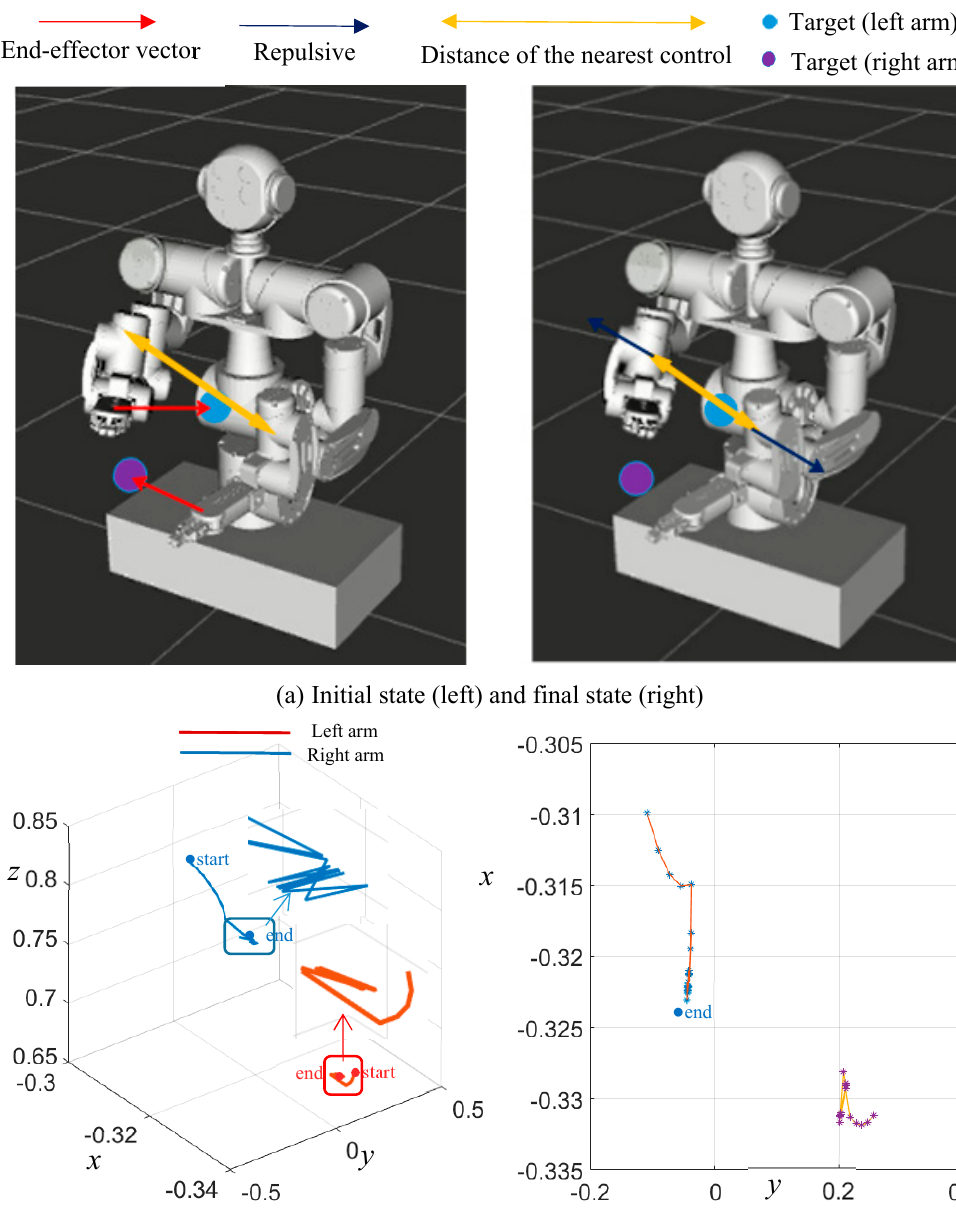
Figure 10. Process of avoiding self-collision in the dual-arm system using the traditional artificial potential field method. Two arms of the dual-arm had different targets. ( a ) The initial state and final state of the robot; ( b ) Trajectory of the end-effector of each arm